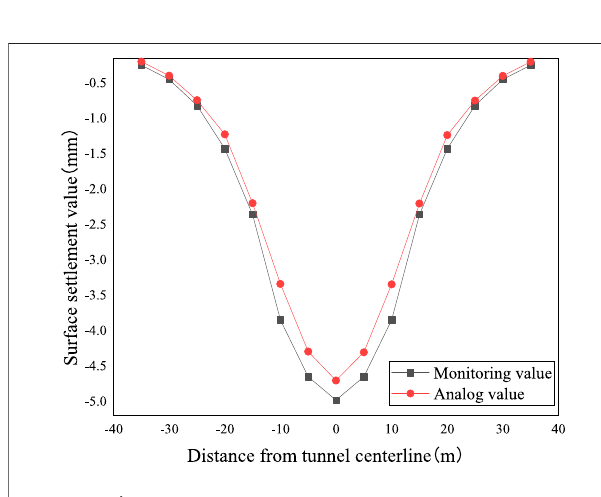
FIGURE 17 | Comparison and analysis of simulation value and monitoring value of the tunnel crossing the boulder stratum.